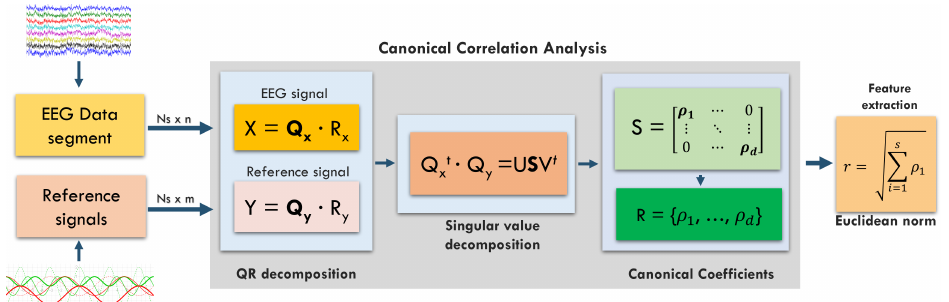
Figure 2. Block diagram for the CCA computation, including